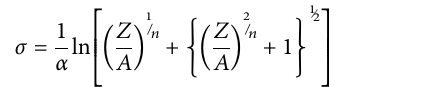
Frontiers in Mechanical Engineering |